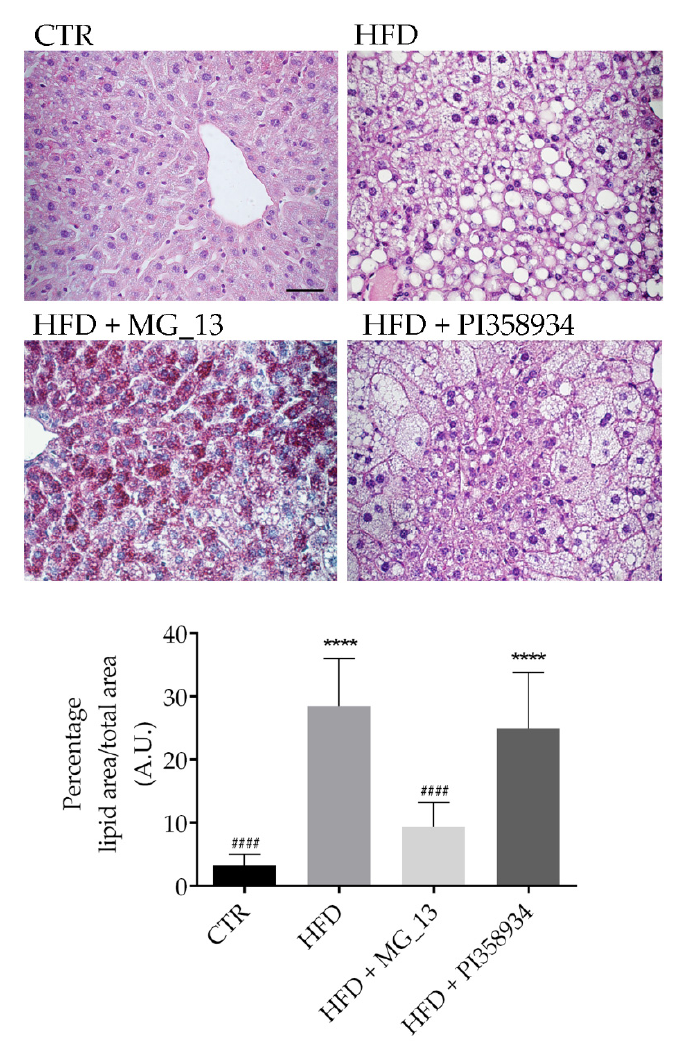
Figure 5. Histochemical features of liver parenchyma of mice. Paraffin sections of mice livers were stained with PAS-hematoxylin and eosin. PAS reaction demonstrated glycogen stores (stained red) in the hepatocytes. The lipid droplets being approximately circular in the section were counted with Image-J software (Bar 50 μ m). Data are shown as a percentage of lipid area/total area and are presented as means ± S.D. of 3 independent experiments and analyzed by one-way ANOVA followed by Dunnett’s multiple comparisons test. (**** p < 0.0001 vs. CTR and #### p < 0.0001 vs. HFD).